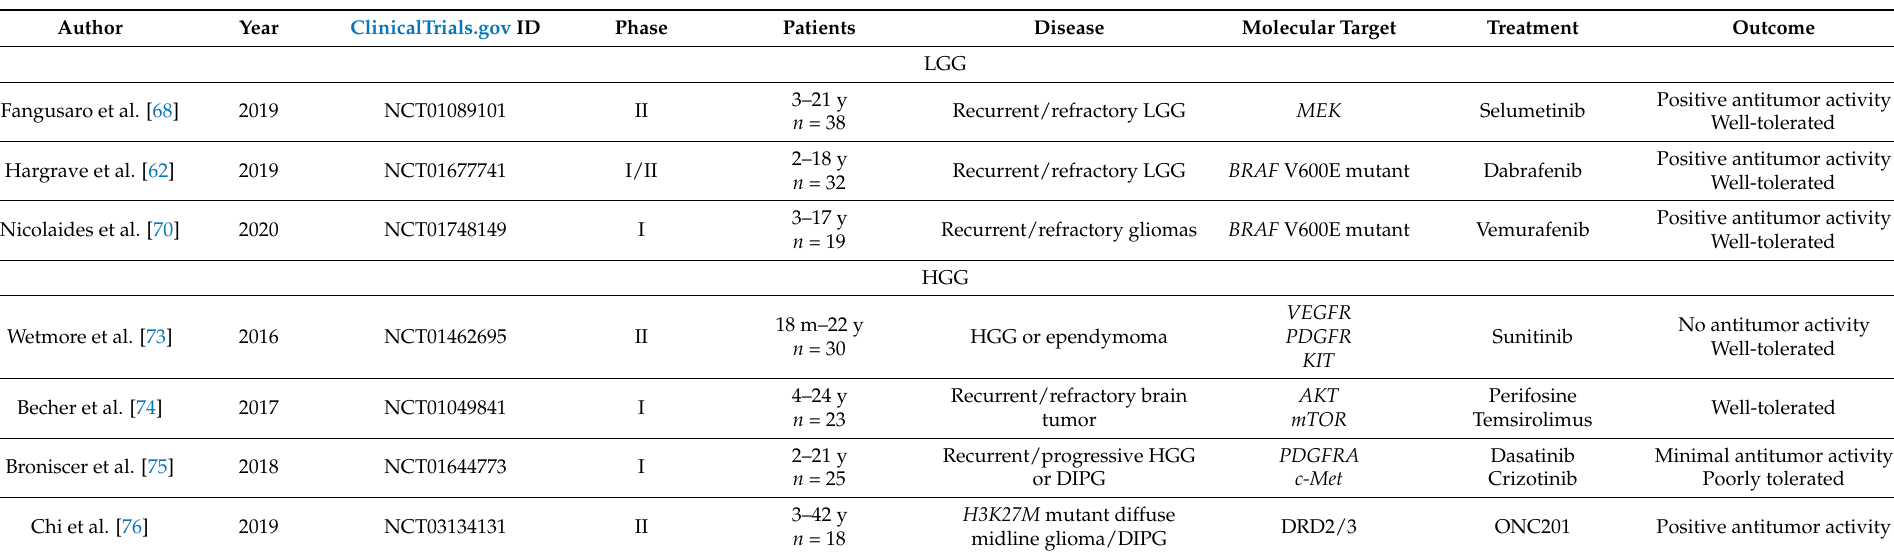
Table 3. Summary of recent clinical trials of targeted therapies for pediatric